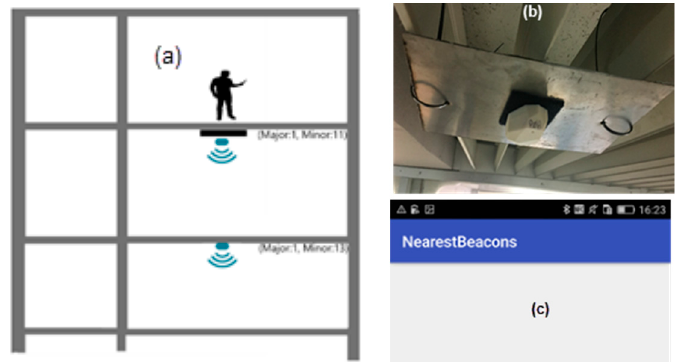
Figure 7. Test of signal blocking with a 20 mm × 200 mm × 2 mm steel plate between the beacon and the ceiling in a corridor (a green region in Figure 3): beacon installation ( b ) and NearestBeacons App results showing no received signal ( c ).